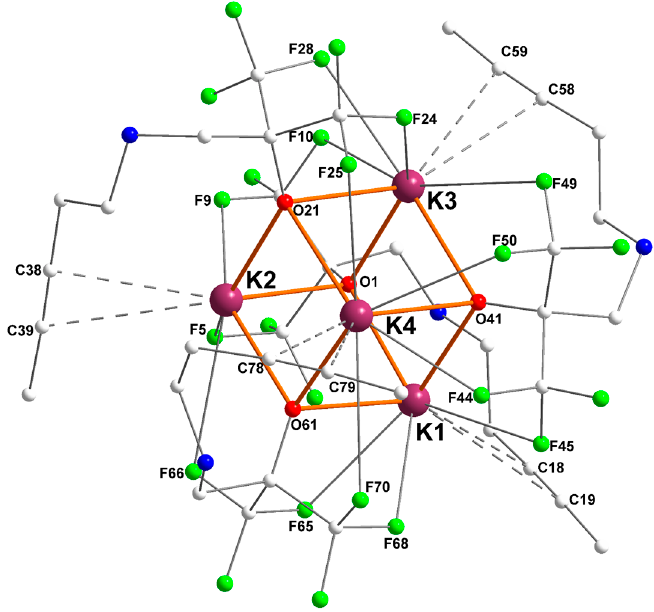
Figure 3. Representation of the molecular solid-state structure of the potassium–alkyne complex [{RO 2 }K] 4 ([ 2 ] 4 ). Color code: purple, K; green, F; blue, N; red, O; grey, C. H atoms omitted for clarity. Table 2. Key metric parameters in the potassium–alkyne complex [{RO 2 }K] 4 ([ 2 ] 4 ). K